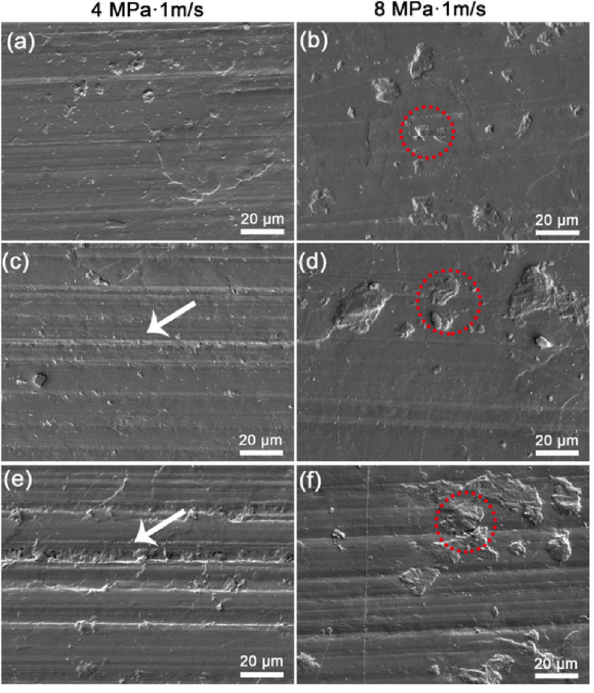
Fig. 7 (a, b) Worn surfaces of PI/AP, (c, d) PI/AP/SiO 2 , and (e, f) PI/AP/BN for sliding against Al 2 O 3 at 4 and 8